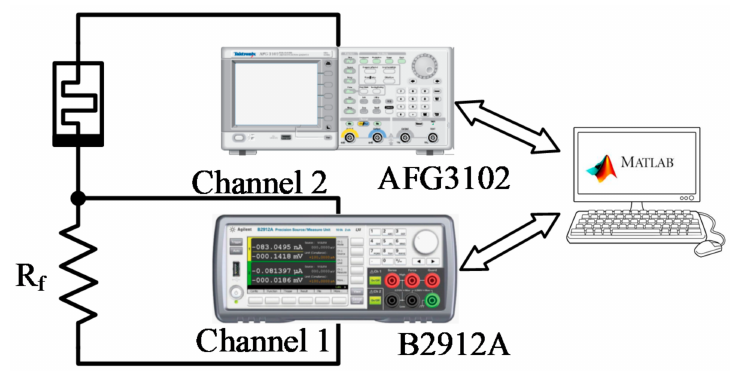
Figure 2. Experimental set-up.